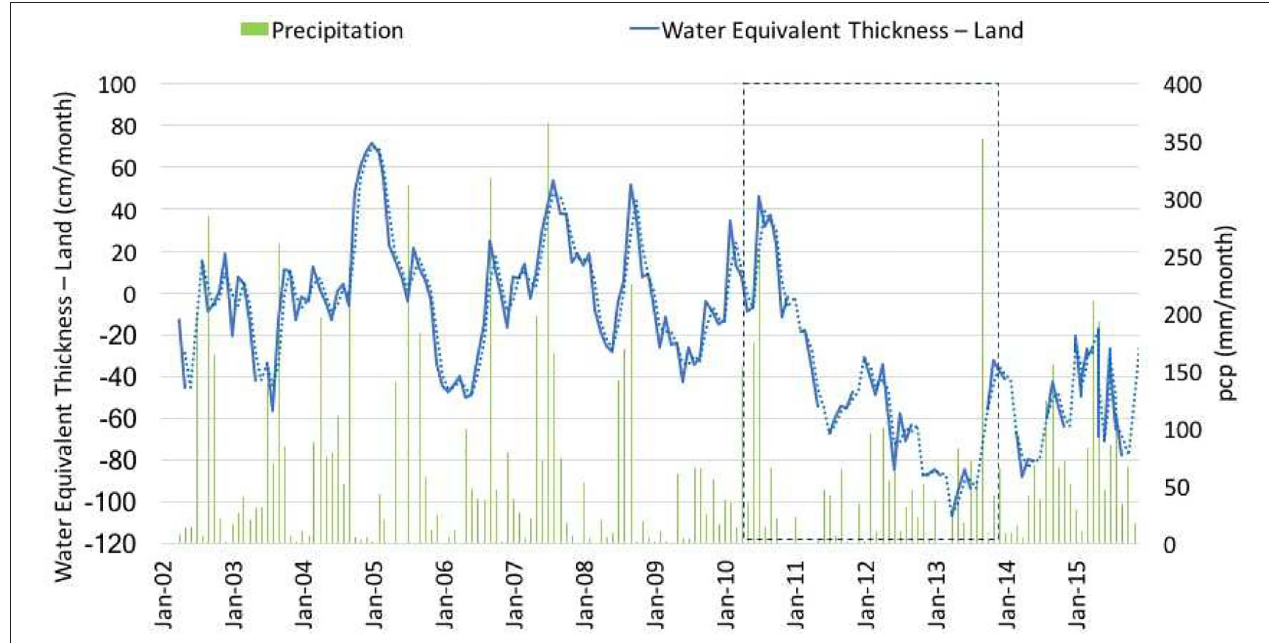
FIGURE 8 | Water equivalent thickness (cm) over the MMA (Data GRACE-JPL). The dotted line corresponds to a smoothed version of the original data, as mean of interpolating missing data. The green bars correspond to monthly precipitation over the MMA. The dashed-line box indicates the periods of a prolonged meteorological drought between the occurrence of